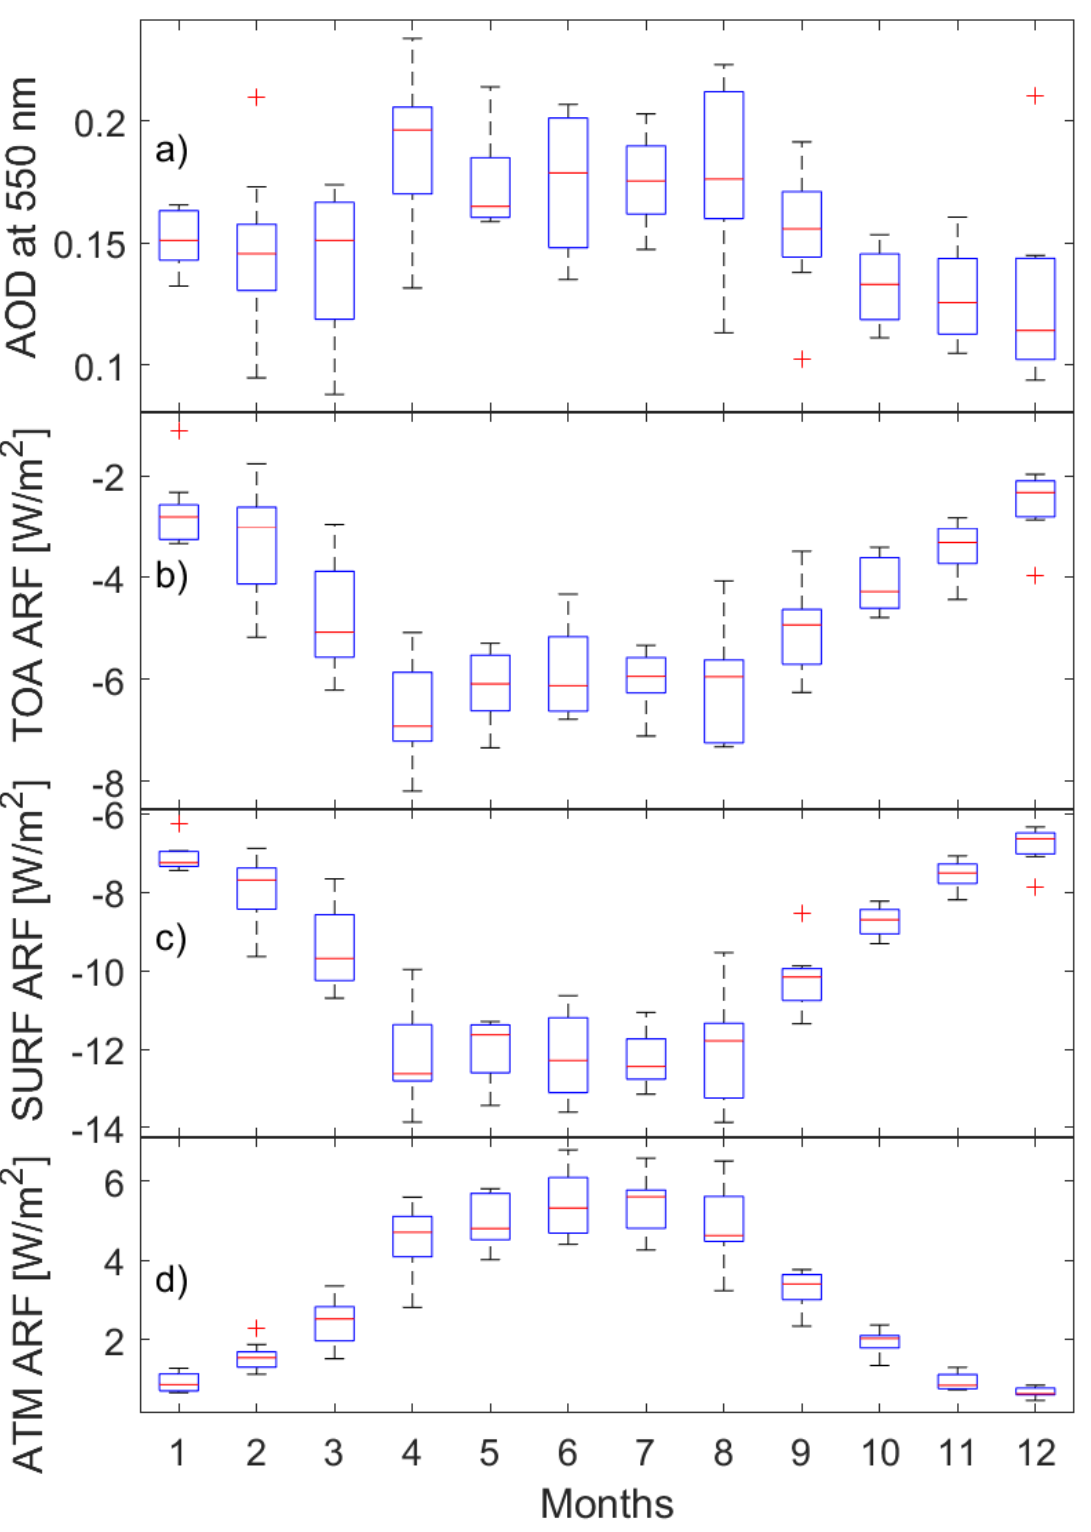
Figure 6. Box-whisker plots for the annual cycle of AOD at 550 nm ( a ), clear-sky TOA ARF ( b ), surface ARF ( c ), and atmosphere ARF ( d ) in [W/m 2 ] for Poland-AOD sites. The red horizontal lines show the median values. The lower and upper boxes correspond to lower (0.25) and upper (0.75) quantiles, while short horizontal lines show the lowest and highest values. The dotted line shows the linear fit.